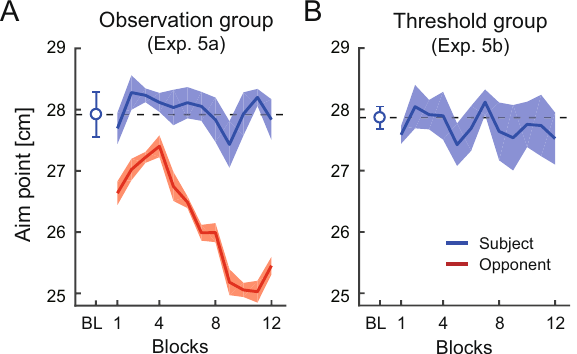
Figure 8. Results of the observation and threshold tasks in Experiment 5. Change of aim point (mean endpoint) when observing the performance of the risk-averse opponent ( A ) and attempting to exceed the required total score. ( B ) Data is averaged across the subjects, and the shaded area denotes the standard error of the mean. The horizontal dashed line indicates the observed mean endpoint at the baseline (50 trials). Unlike the competition with the risk-averse opponent, the change of the aim point was not induced solely by observing the opponent’s performance or achieving the required total